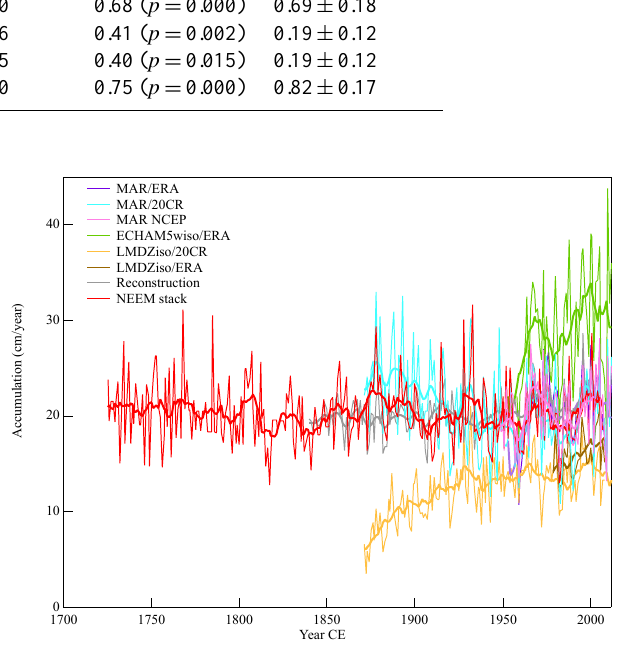
Figure 7. Comparison of NEEM accumulation with the reconstruc- tion and precipitation from simulations, in cm of water equivalent per year. Results are shown for annual averages, as well as for a 11-year binomial